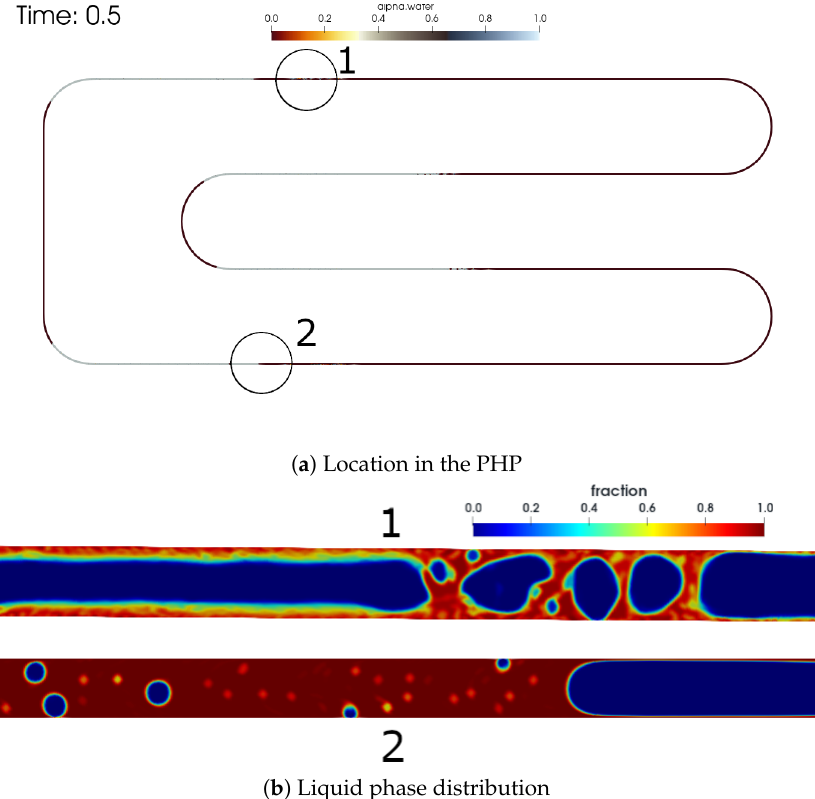
Figure 16. Numerical results of the Lee model [27] in 0.5 s for 100 W input